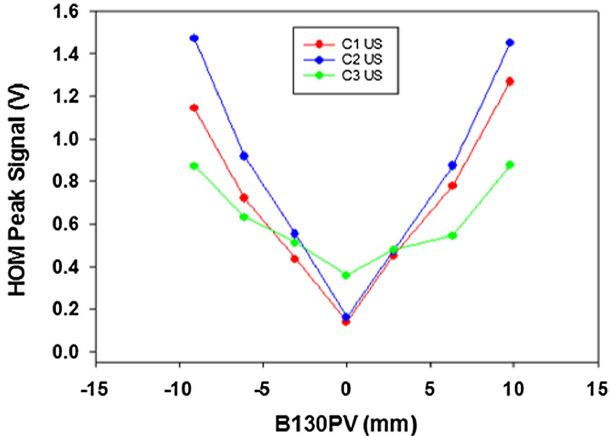
FIG. 10. Beam-offset-monitor plot for B130 with 400 pC = b at entrance to CM2 and the first three cavities. We used 300-shot averages.